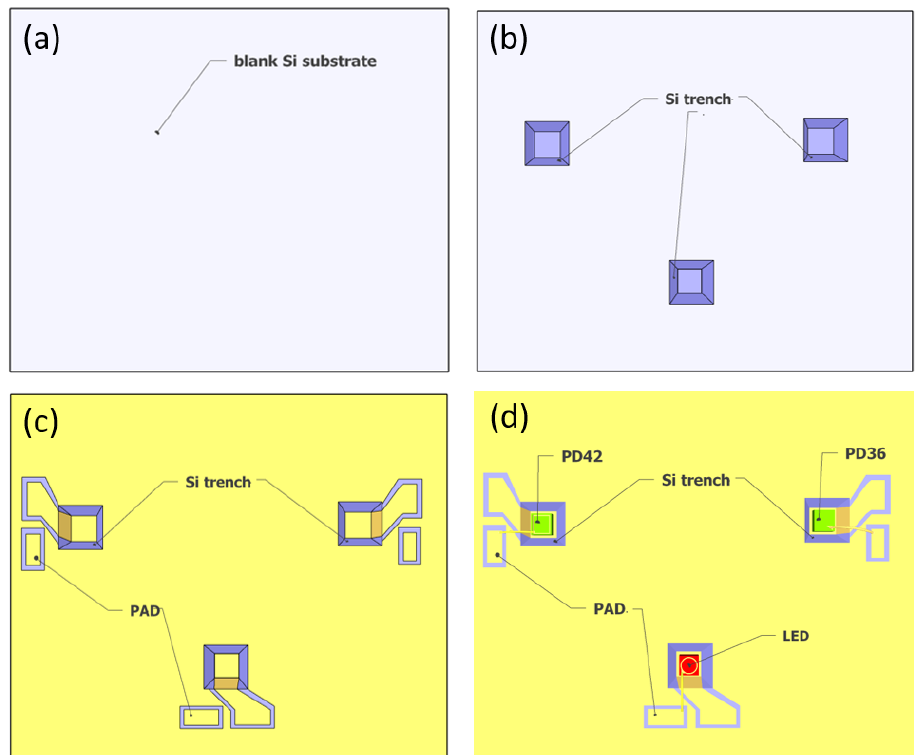
Figure 5. Fabrication process flow of the bottom substrate containing the LED/photodiode chips. ( a ) Blank silicon substrate. ( b ) Three trenches are formed on the substrate via selective etching of silicon by KOH. ( c ) Gold deposition and lift-off. In this step, two contact pads (anode and cathode) are formed for the LED/photodiodes. The deposited gold on the bottom substrate acts as a reflector for the integrating cylinder. ( d ) LED/photodiodes bonding and wire bonding. The LED/photodiode chips are bonded in the trench using die bonding, after which the top contacts of the LED/photodiodes are wire-bonded to the anode